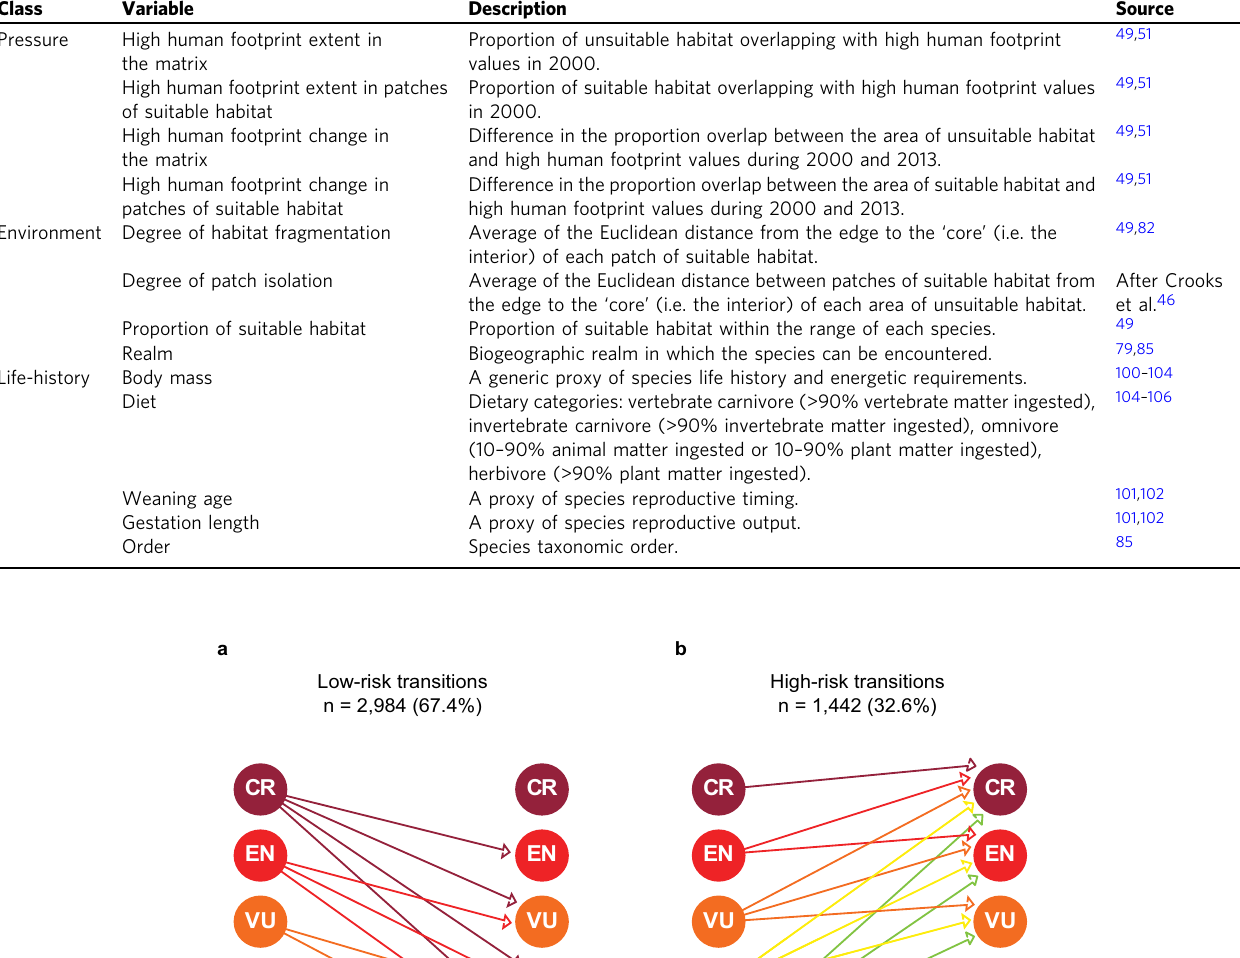
Table 1 Description of the selected variables to predict extinction risk transitions in terrestrial